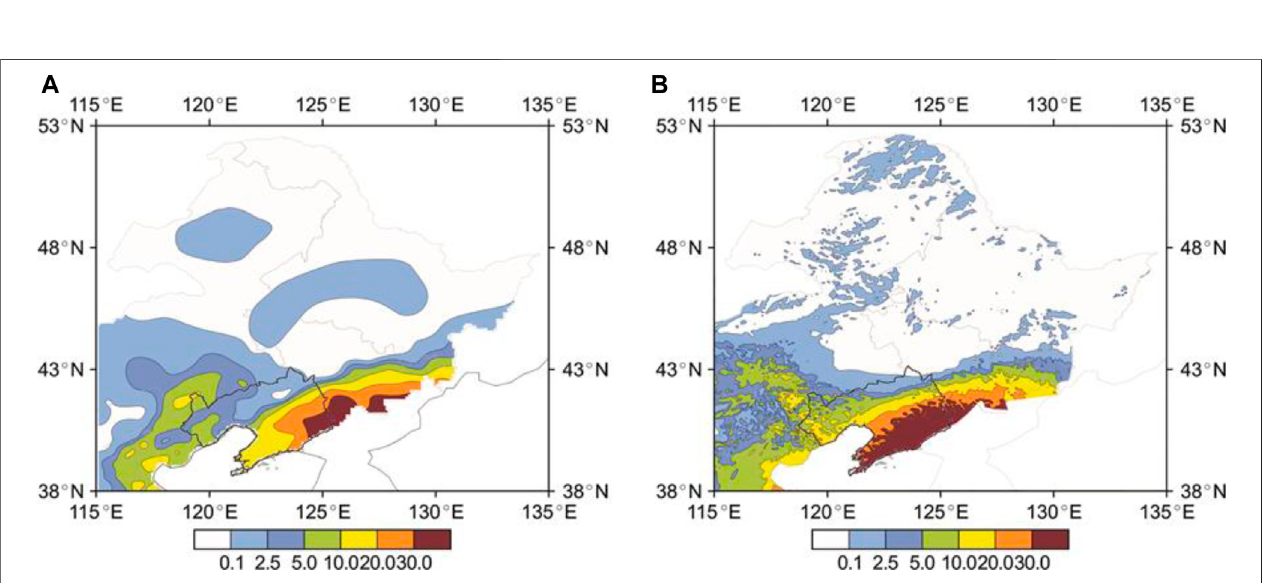
FIGURE 5 | Comparison of observed snowfall (A) and simulated snowfall (B) from 0:00 on Day 1 to 0:00 on Day 2.